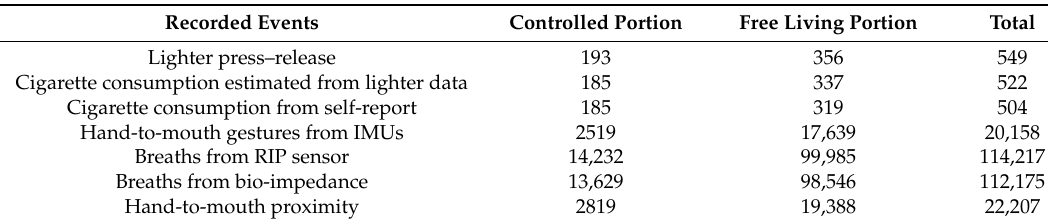
Table 3. Recorded information from the study data of 40 subjects.